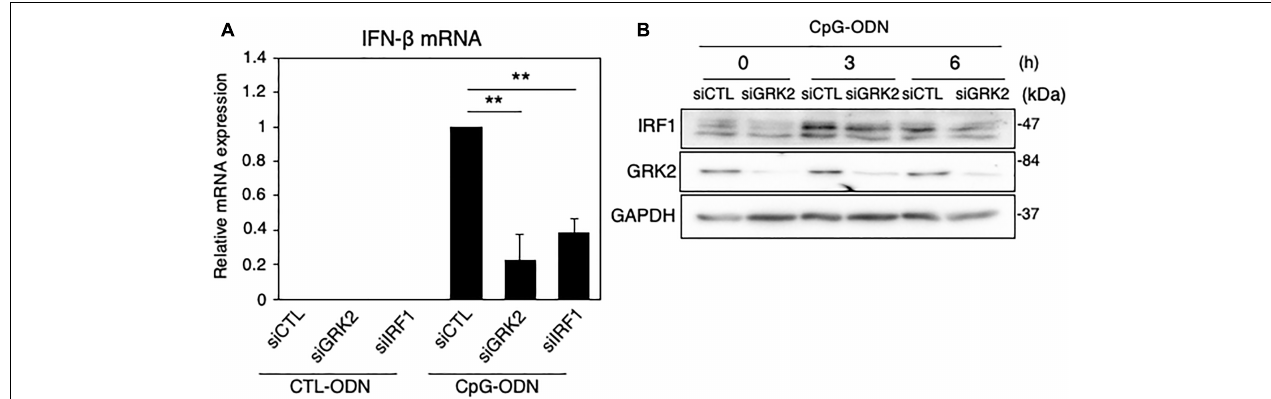
FIGURE 6 | Effect of GRK2 siRNA transfection on TLR9-mediated IRF1 and IFN- β expression in MG6 cells. (A) IFN- β mRNA expression 3 h after 1 µ M CpG-ODN or control ODN (CTL-ODN) application in the presence of GRK2 siRNAs (siGRK2), IRF1 siRNAs (siRF1) or the negative control siRNAs (siCTL). The mRNA levels were expressed as a fold increase above control normalized GAPDH and the results represent the mean ± SEM for three independent experiments. ∗∗ P < 0.01 by t -test. (B) Changes in protein expression of IRF1 and GRK2 after 1 µ M CpG-ODN challenge in the presence of GRK2 siRNAs (siGRK2) or the negative control siRNAs (siCTL). GAPDH served as loading control. Shown are representative Western blots from three independent experiments in which the same results were obtained.